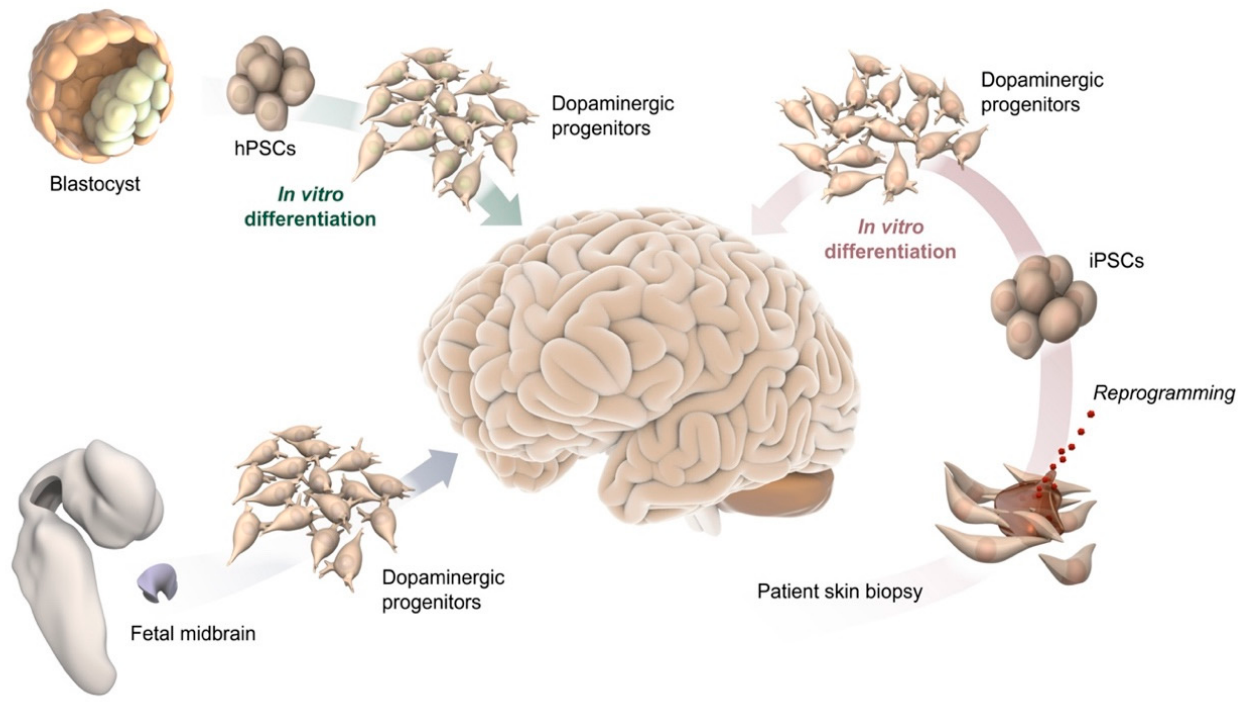
Figure 1. Schematic illustration of potential DA progenitor sources for modeling VM differentiation and for therapeutic application in PD, including blastocysts and their pluripotent stem cell derivative (top-left), fetal midbrain tissue (bottom left), and somatic cells from adult individuals, such as a skin biopsy used to reprogram cells to pluripotency (bottom- right).